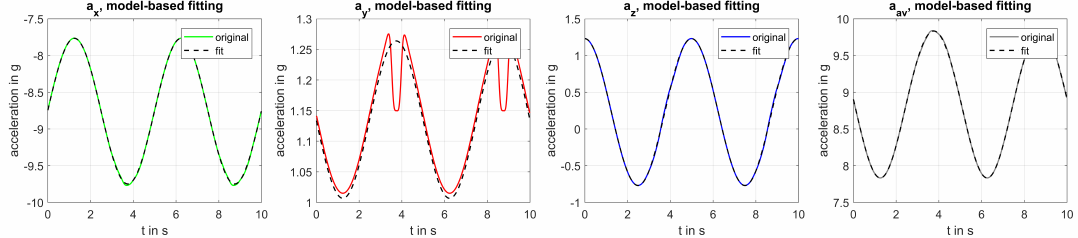
Figure 7. Model-based fitting for bending due to tower-shadow with sensor mounting position simulated as β = γ = 0° and R =